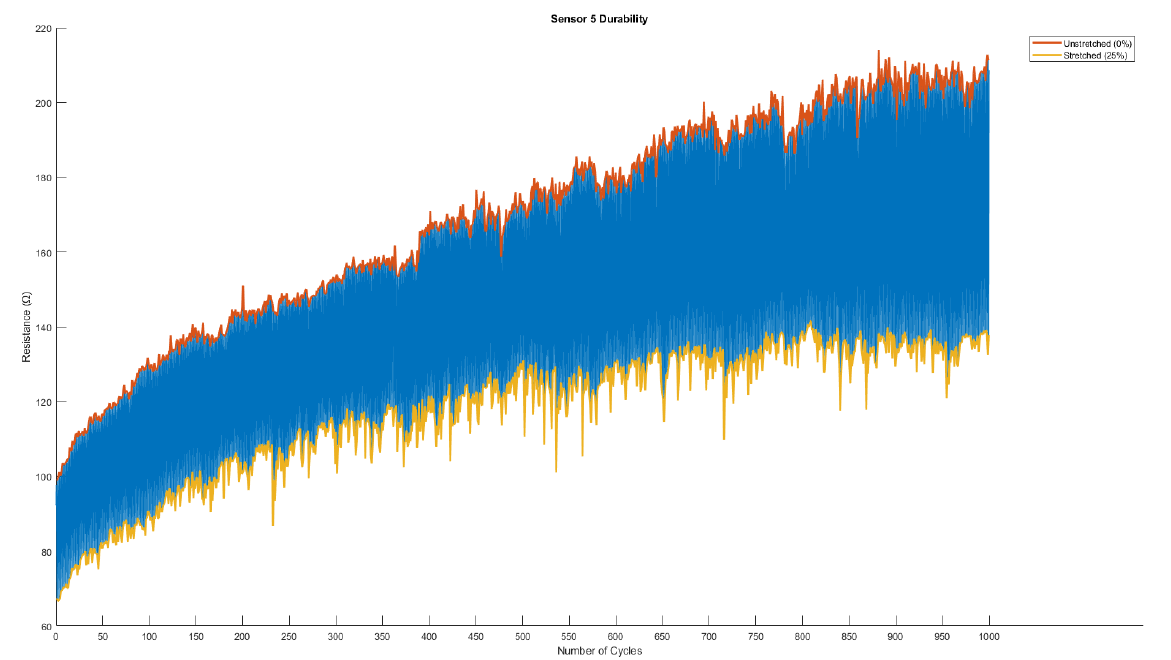
Figure A5. Durability Result (Sensor-5).